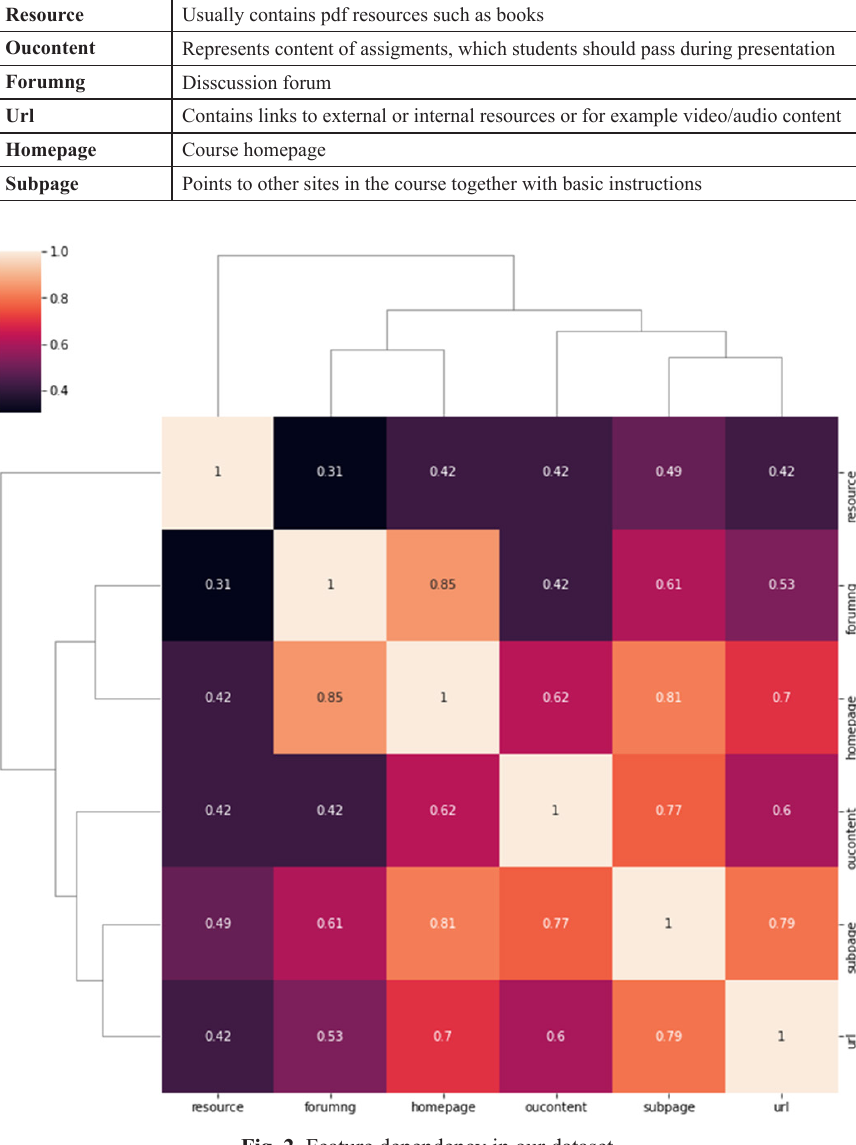
Fig. 2. Feature dependency in our